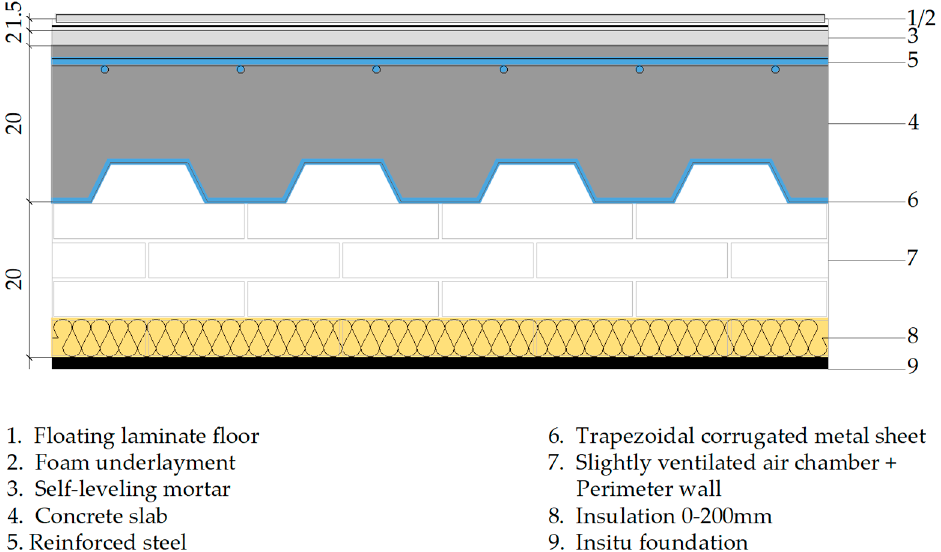
Figure A2. Intermediate floor components detail.